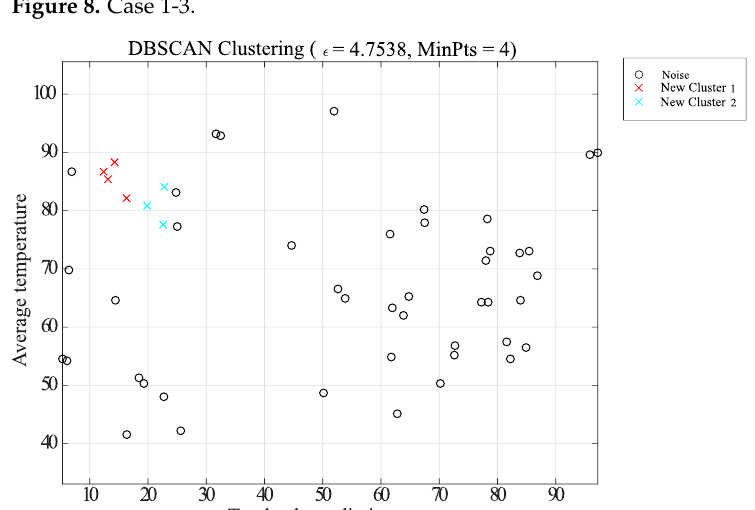
Figure 8. Case 1-3.